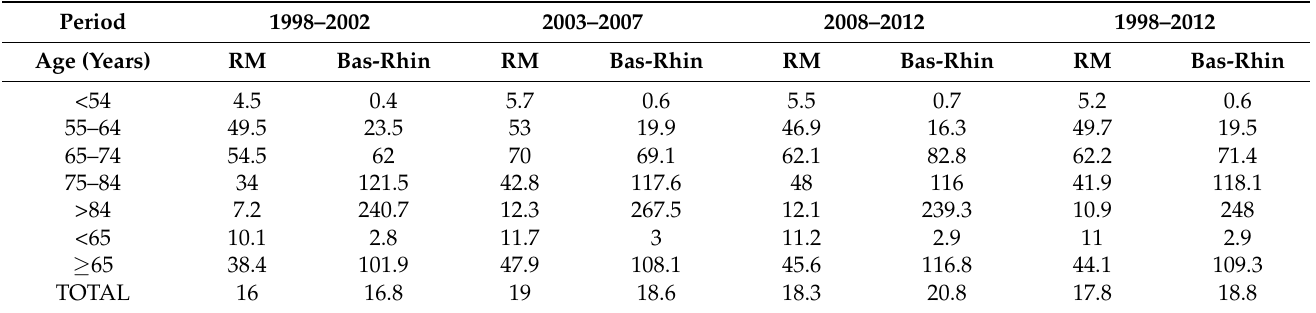
Table 1. Crude incidence rates/100,000 person-years for type I endometrial carcinoma, by age and period in the Region of Murcia (RM) and Bas-Rhin area, 1998–2012.